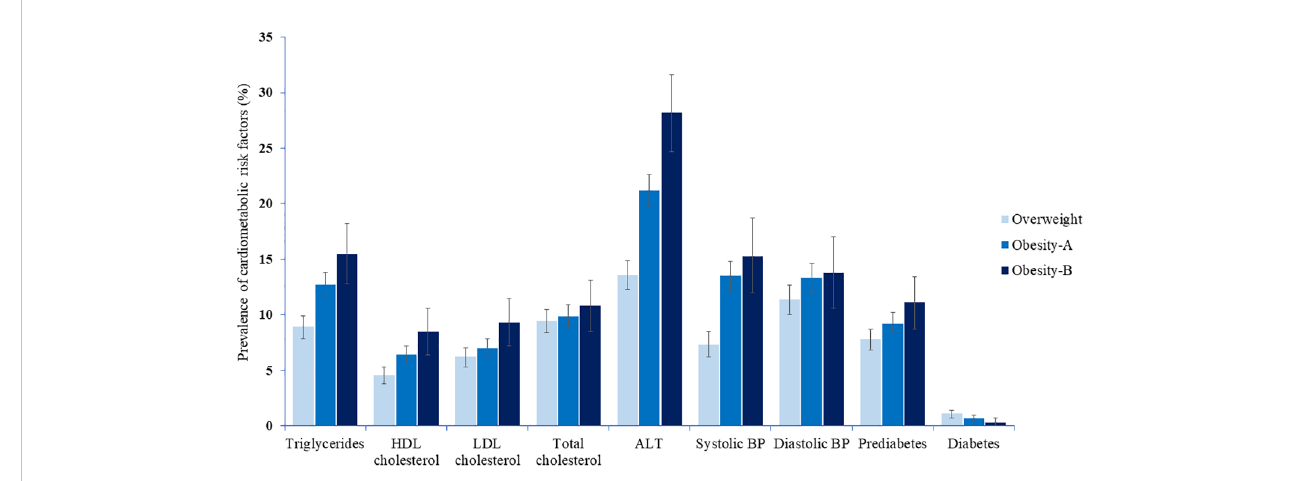
FIGURE 1 The prevalence of cardiometabolic risk factors among children and adolescents by weight